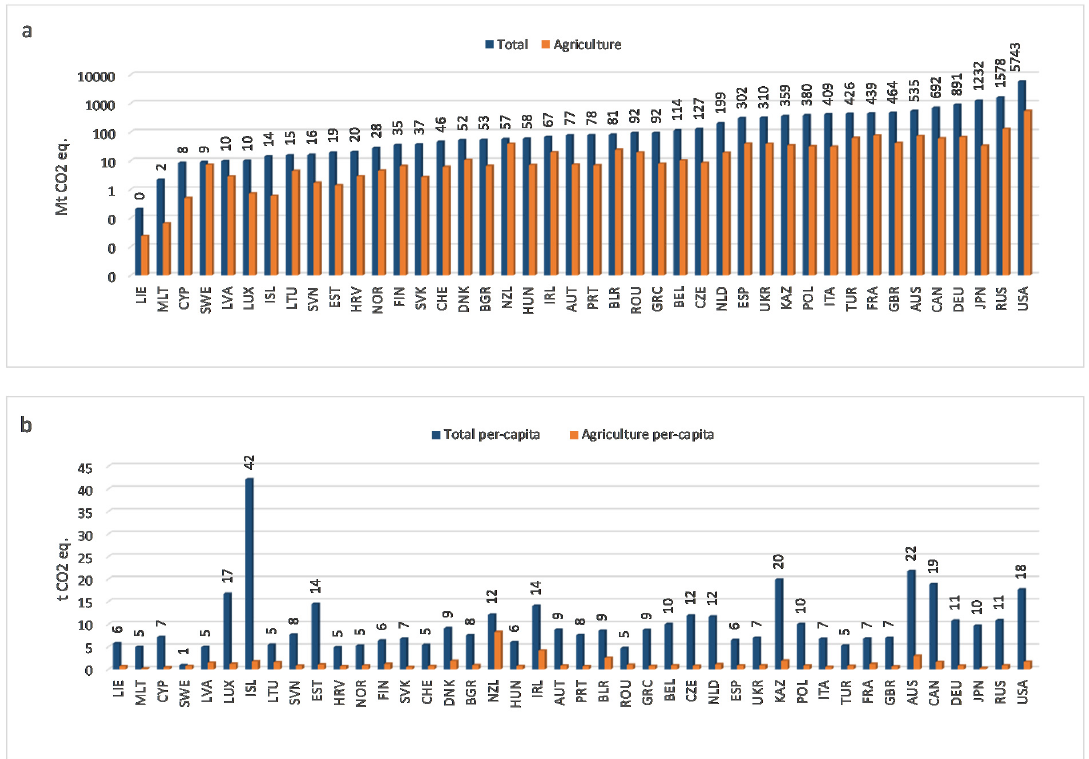
Figure 1. The total emission from Annex I countries in comparison to agricultural emissions for 2017 with a logarithmic scaling ( a ), and the total and agricultural emissions per capita ( b ). Numbers indicate the amount of total GHG emissions in Mt CO 2 equivalent in each country ( a ), and the amount of total GHG emissions per capita in t CO 2 equivalent ( b ).